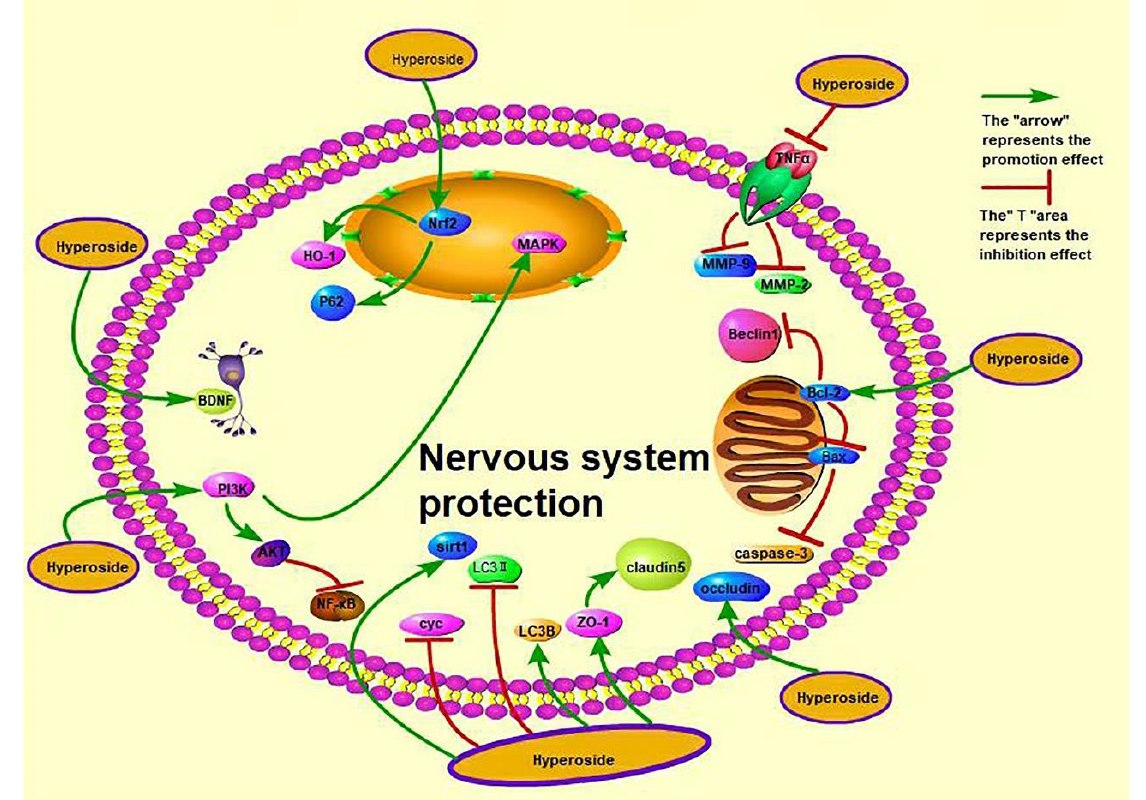
Figure 4. Nerve-protective effect of hyperoside.